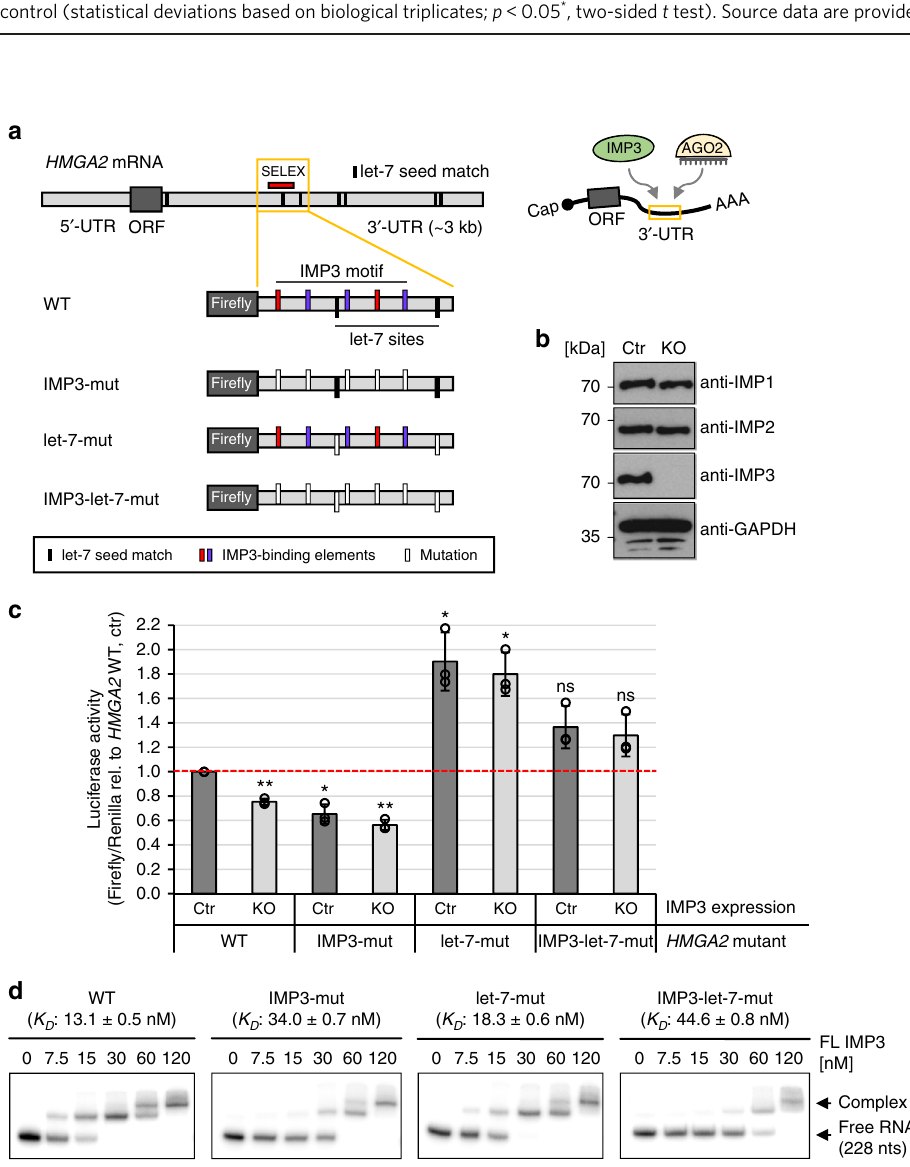
Fig. 7 SELEX-derived consensus array in natural IMP3 targets. a For four selected 3 ′ -UTRs ( RPL32 as a negative control and SLC6A14 , UHMK1 , and HMGA2 as IMP3 targets) and exon 29 of ANKRD17 , the iCLIP-tag distribution of IMP3 in HepG2 cells (above the horizontal lines) and the distribution of CA-/GGC elements (in violet/red, below the lines) are schematically represented. In addition, the positions of motif arrays (in brown) are indicated. Binding indices are given in parentheses, re fl ecting normalized iCLIP-tag densities in the respective 3 ′ -UTRs. For one of the motif arrays of ANKRD17 exon 29, a detailed sequence comparison with the optimal, designed motif array in the 101-mer RNA is shown. b Global correlation of IMP3 RNA binding and motif array distribution, represented as a density plot of B index for 3 ′ -UTRs grouped by the number of motif arrays (0, 1, 2/3, and ≥ 4). In the enlarged segment, the mean values of B indices and the number of 3 ′ -UTRs in each data group are given. c Validation of IMP3 binding, using RIP assays from HepG2 lysates (anti- IMP3 and anti-FLAG antibodies), followed by RT-qPCR assays for predicted IMP3 targets ( SLC6A14 , UHMK1 , and HMGA2 ), with RPL32 as negative, and ANKRD17 as positive control (statistical deviations based on biological triplicates; p < 0.05 * , two-sided t test). Source data are provided as a Source Data fi le